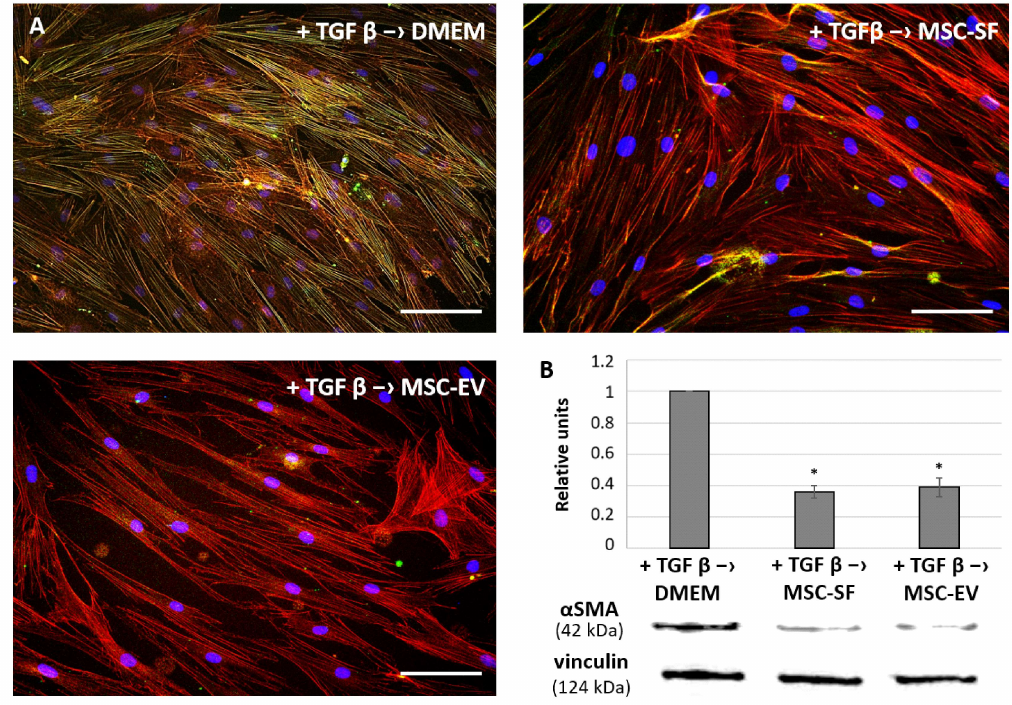
Figure 6. MSC-CM fractions added after the TGFbeta treatment reversed the TGFbeta-induced increase of aSMA expression and its redistribution into stress fibers in fibroblasts. Analysis of aSMA expression in the fibroblasts after exposure to TGFbeta ( + TGFbeta) and the subsequent replacement of growth medium by the components of MSC-CM ( + TGFbeta – > MSC-EV; + TGFbeta – > MSC-SF) or control serum-free DMEM ( + TGF b – > DMEM). ( A ) Immunofluorescence analysis (aSMA (green), phalloidin (red), DAPI (blue)). Scale bar: 100 µ m. ( B ) Western blotting. * p < 0.05 (compared to TGFbeta – > DMEM